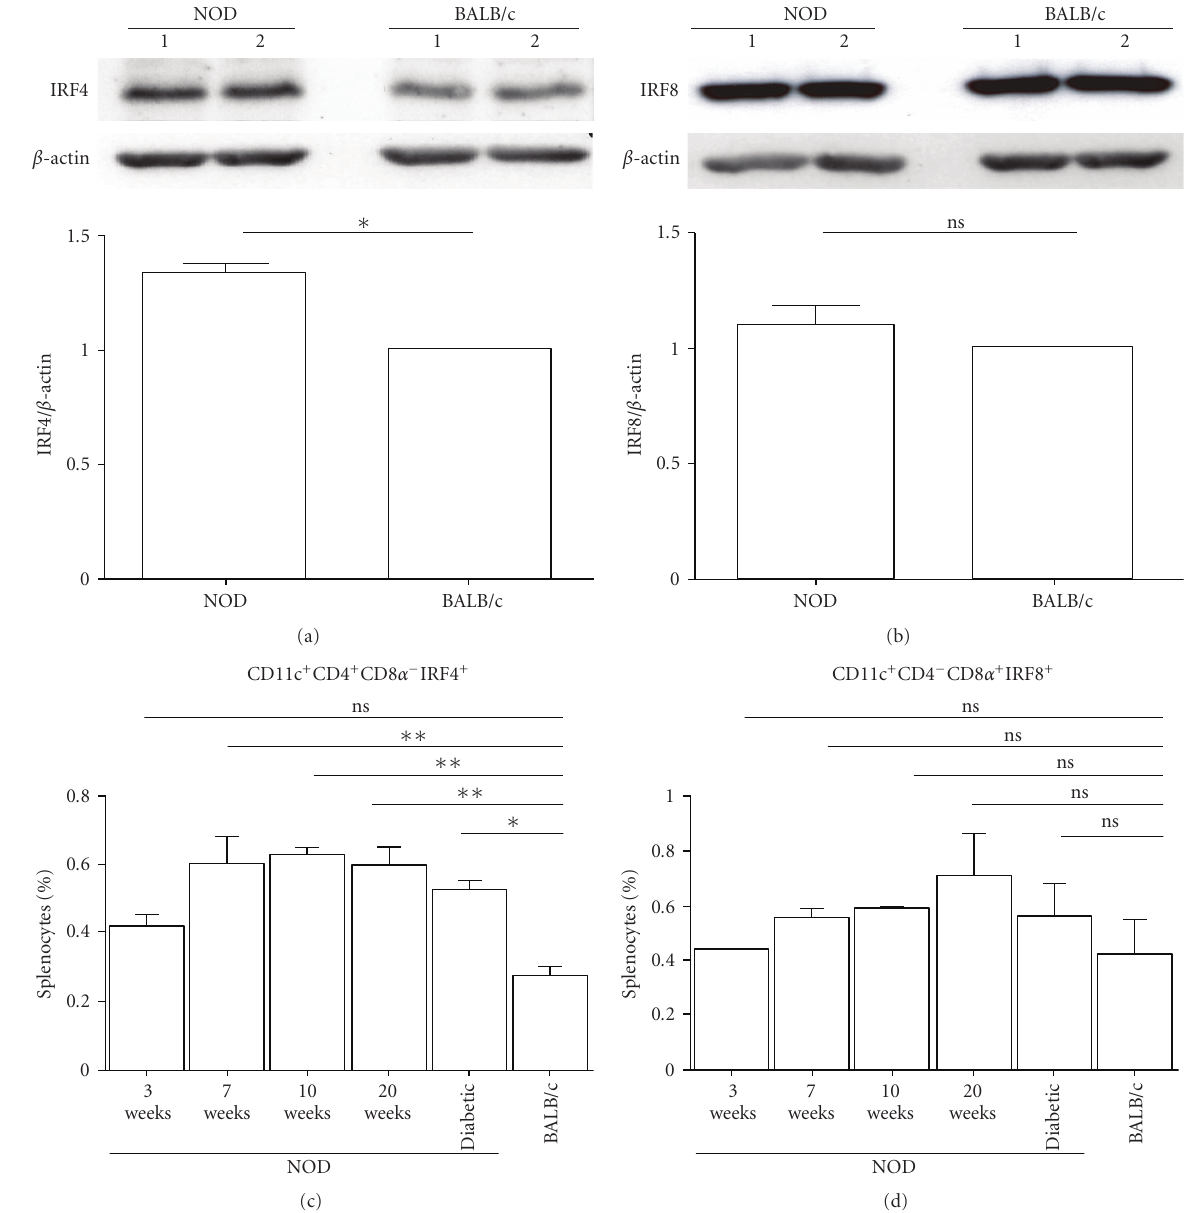
Figure 3: Expression of IRF4 in splenic DCs of diabetes-prone NOD mice and diabetes-resistant BALB/c mice. Proteins were extracted from CD11c + -purified splenic DCs from NOD and BALB/c mice and analyzed by Western blotting for (a)IRF4 or (b) IRF8 expression. The relative intensities of the bands were assessed using the NIH Image software and normalized to reference actin bands to establish a ratio of IRF4/actin (a), lower panel) and (b), lower panel) IRF8/actin. The expression levels observed in BALB/c were arbitrarily set as a unitary value. Data are representative of 2 independent experiments (Exp1 and Exp2). (c) and (d) splenocytes from NOD and BALB/c mice were stained for the CD11c, CD4, and CD8 α surface markers in combination with intracellular staining with an anti-IRF8 or anti-IRF4 mAb and analyzed by flow cytometry. Data represent the average percentage of CD11c + CD4 + CD8 α − IRF4 + -positive (c) and CD11c + CD4 − CD8 α + IRF8 + -positive (d) cells of two independent experiments. Error bars correspond to the averages ± S.D ( ∗ P < . 05, ∗∗ P < . 01 and ∗∗∗ P < . 001).